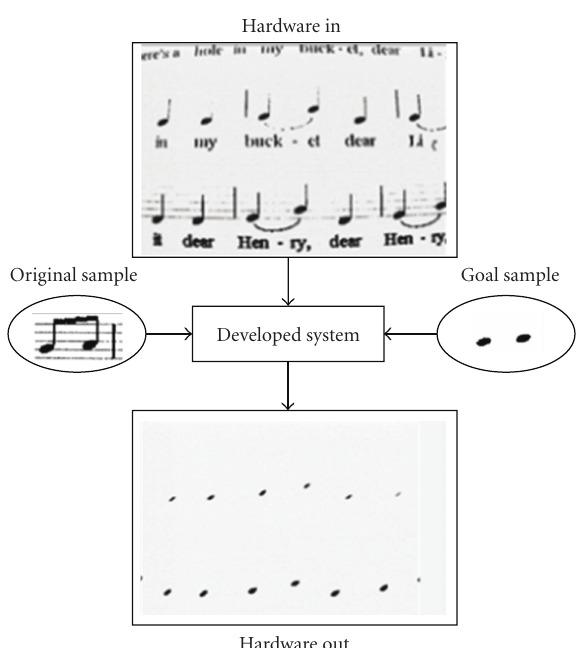
Figure 11: Obtained result by developed hardware for head extraction in real time.